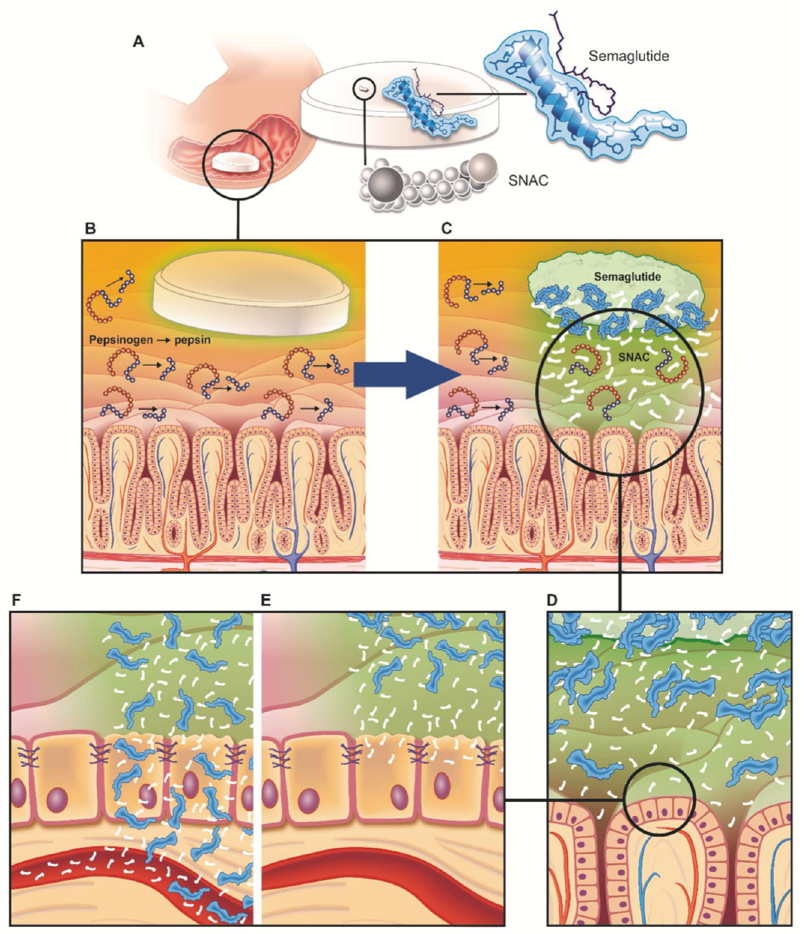
Figure 6. Formulation design of the Rybelsus ® tablet and schematic diagram of the semaglutide absorption enhancement mechanism of SNAC (published by the Novo Nordisk research team) [61]. The Rybelsus ® tablet ( A ) is completely eroded from the gastric mucosal surface ( B , C ) and SNAC increases the local pH to prevent the degradation of semaglutide from pepsin ( C ). Moreover, it indirectly weakens the self-association of semaglutide and helps to maintain the monomer state ( D ), and increases transcellular absorption by increasing membrane fluidity ( E , F ). Reprinted with permission from ref. [61]. Copyright 2018 Science .